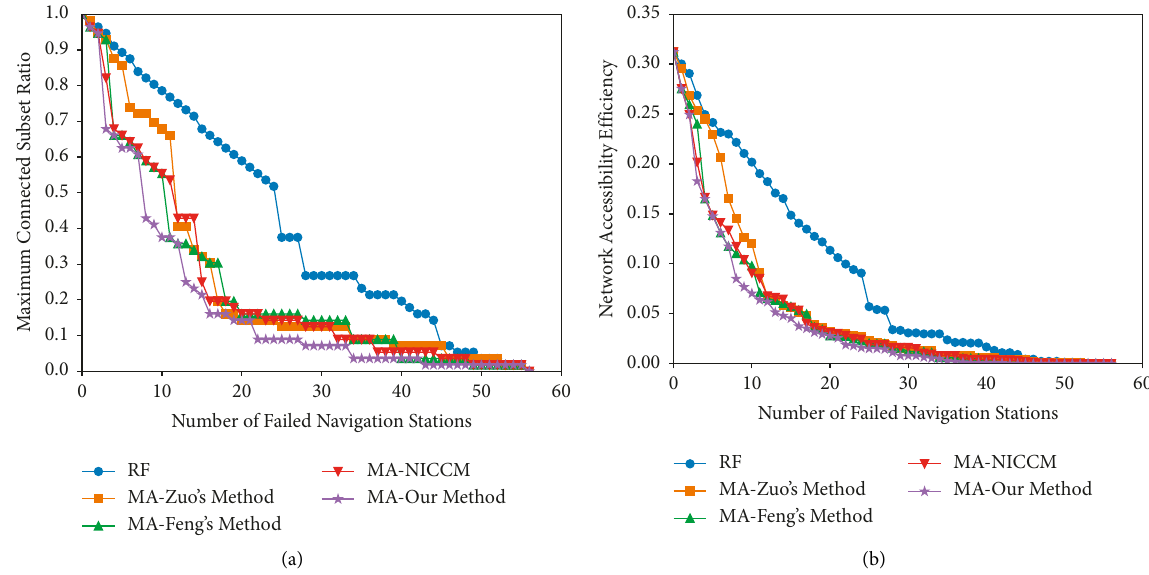
Figure 4: Network topology and function changes under different failure scenarios of navigation stations: (a) Maximum connected subset. (b) Network accessibility